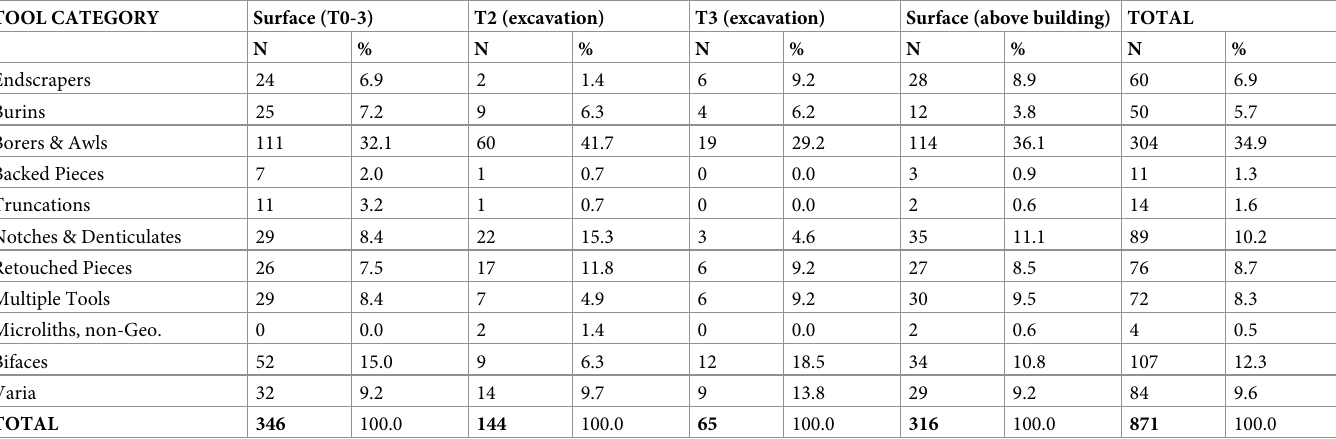
Table 7. Tool categories–Kaizer Hill Terraces.